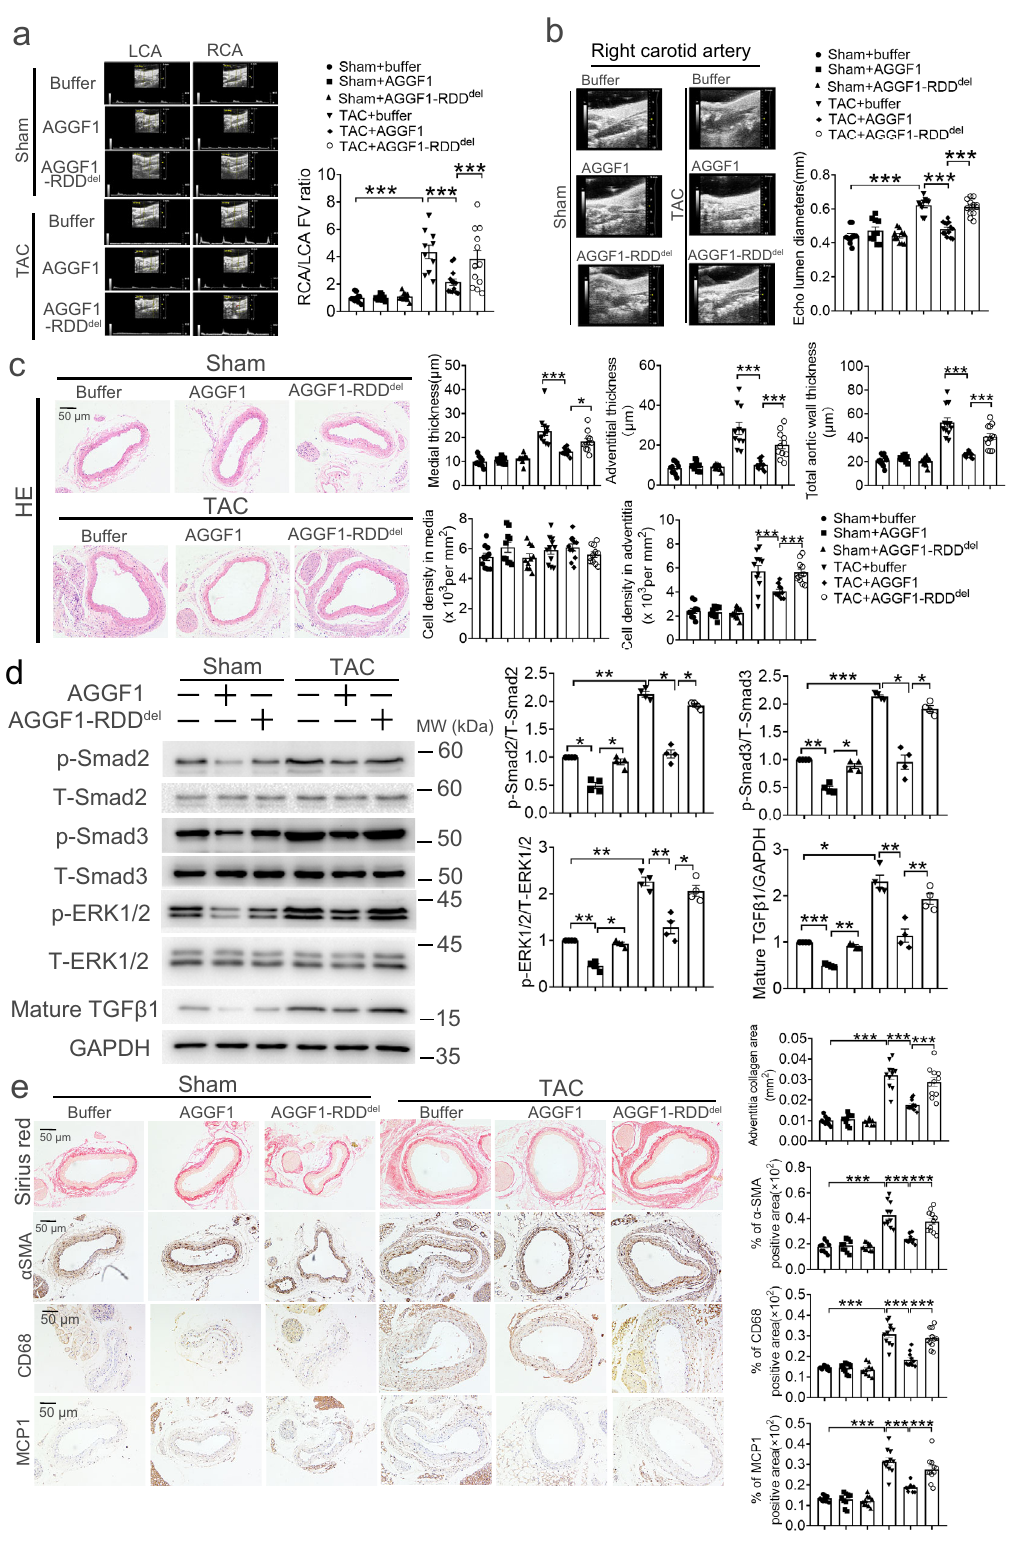
AGGF1 blocks TGF- β 1 signaling, ERK1/2 signaling, and in fl am- mation in VSMCs To substantiate the in vivo fi ndings in Aggf1 +/ − mice and smcKO mice, we characterized the effects of AGGF1 on TGF- β 1 signaling in cultured VSMCs.WetreatedVSMCswithdifferentconcentrationsofTGF- β 1and found that TGF- β 1 induced phosphorylation of Smad2/3 and ERK1/2 in